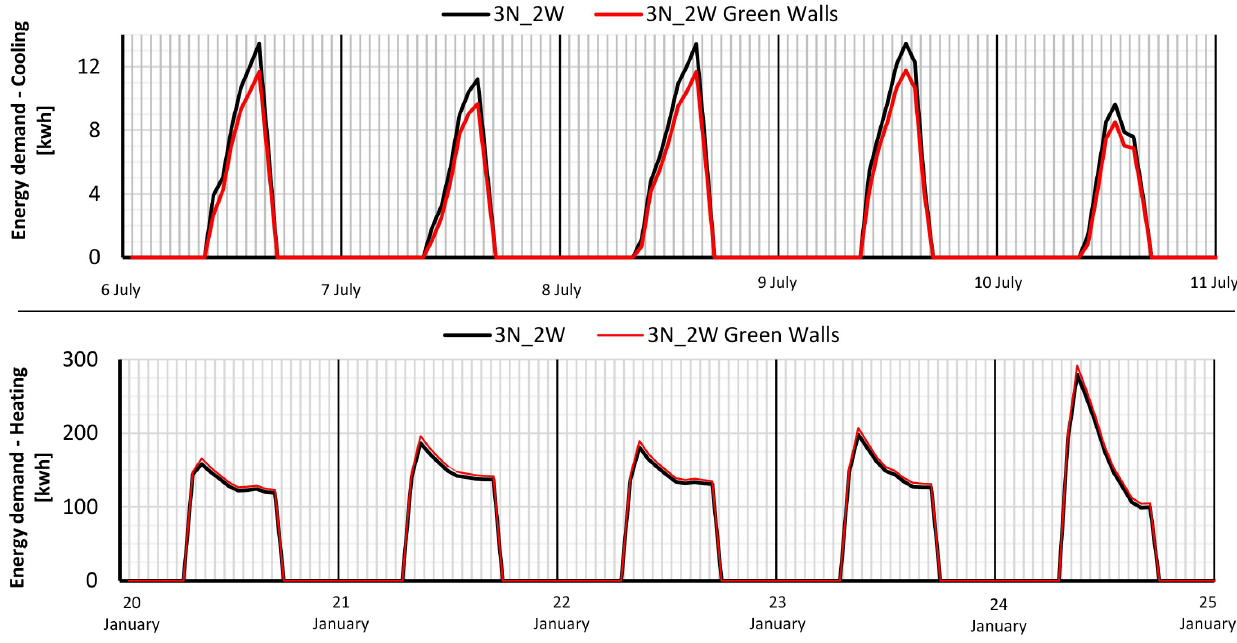
Figure 6. Trend of the external surface temperature (°C) and surface heat gains/losses (kW) in the winter reference week for the western wall.